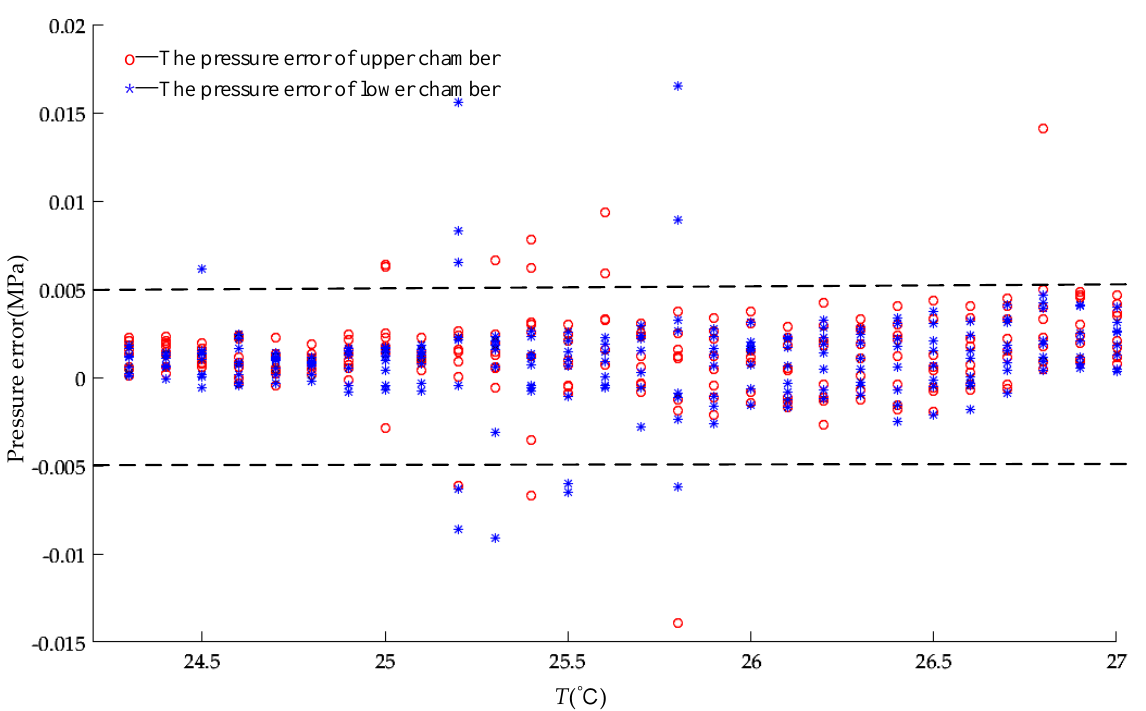
Figure 12. Pressure error of upper and lower chambers when injecting filtered air.